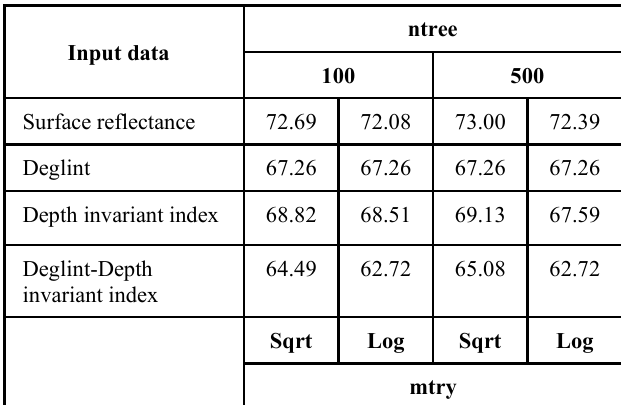
Figure 3 . Error with number of tree (Scenario 1 with ntree= 500 and